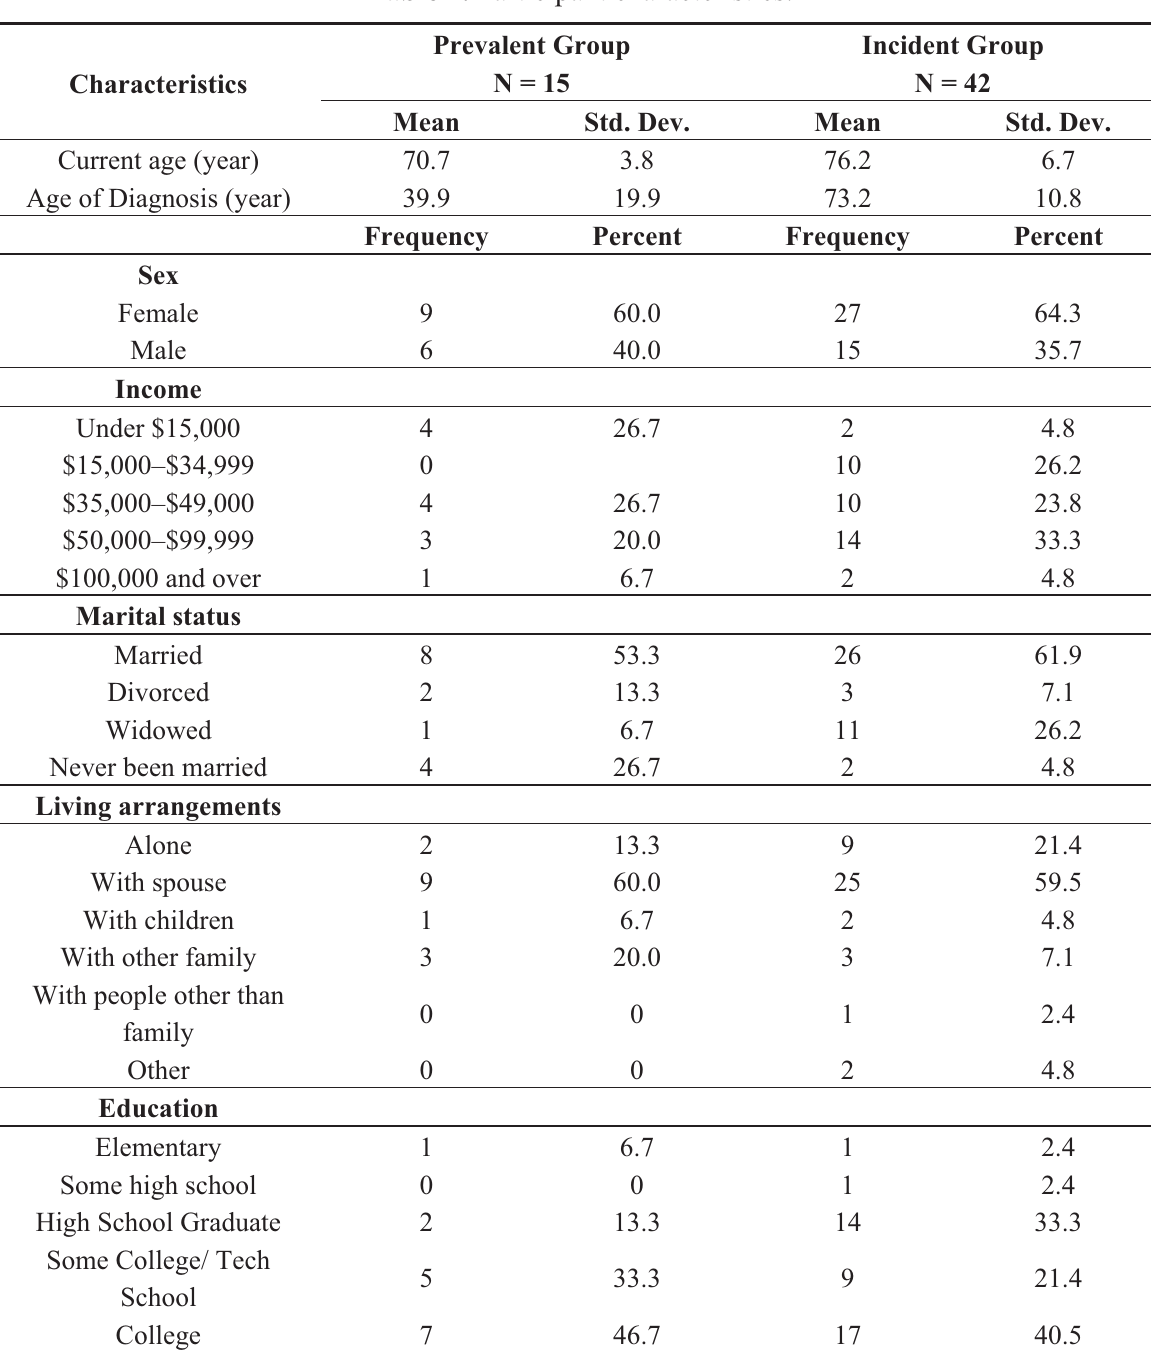
Table 1. Participant